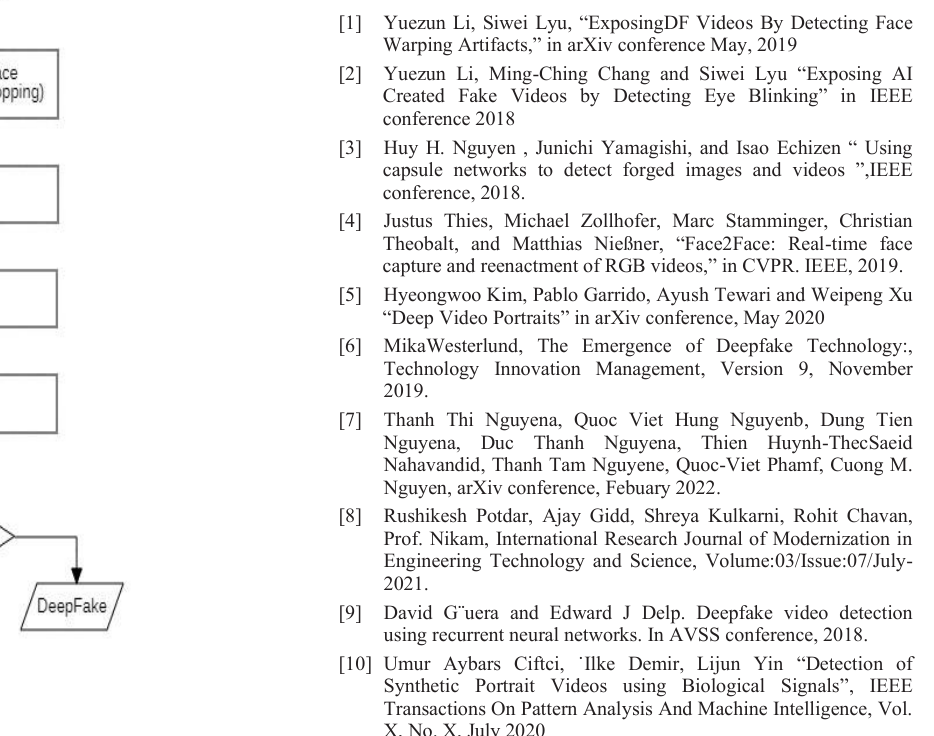
Fig. 6. Training Flow